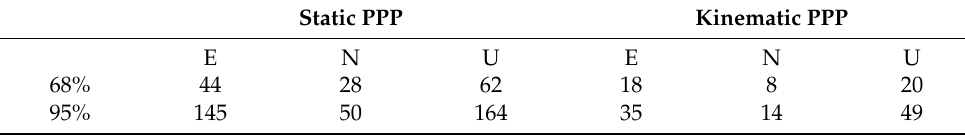
Table 14. Convergence time of the QF method (unit: min) (G/R/E). Static PPP Kinematic PPP